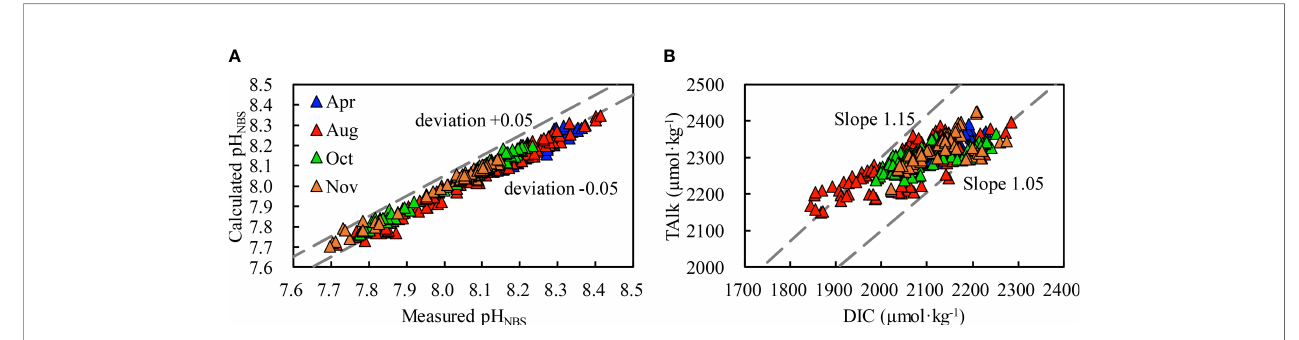
FIGURE 2 | Evaluation of data quality for seasonal mapping cruises in 2019, including the relationship between calculated pH NBS and measured pH NBS (A) and between TAlk and DIC (B) . The two dashed lines in panel (A) show a deviation of ± 0.05, and the two dashed lines in panel (B) show TAlk – DIC ratios of 1.05 and 1.15,